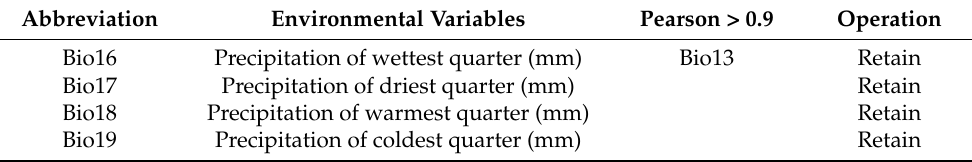
Table 1. Cont. Abbreviation Environmental Variables Pearson > 0.9 Operation Bio16 Precipitation of wettest quarter (mm) Bio13 Retain Bio17 Precipitation of driest quarter (mm) Retain Bio18 Precipitation of warmest quarter (mm) Retain Bio19 Precipitation of coldest quarter (mm) Retain